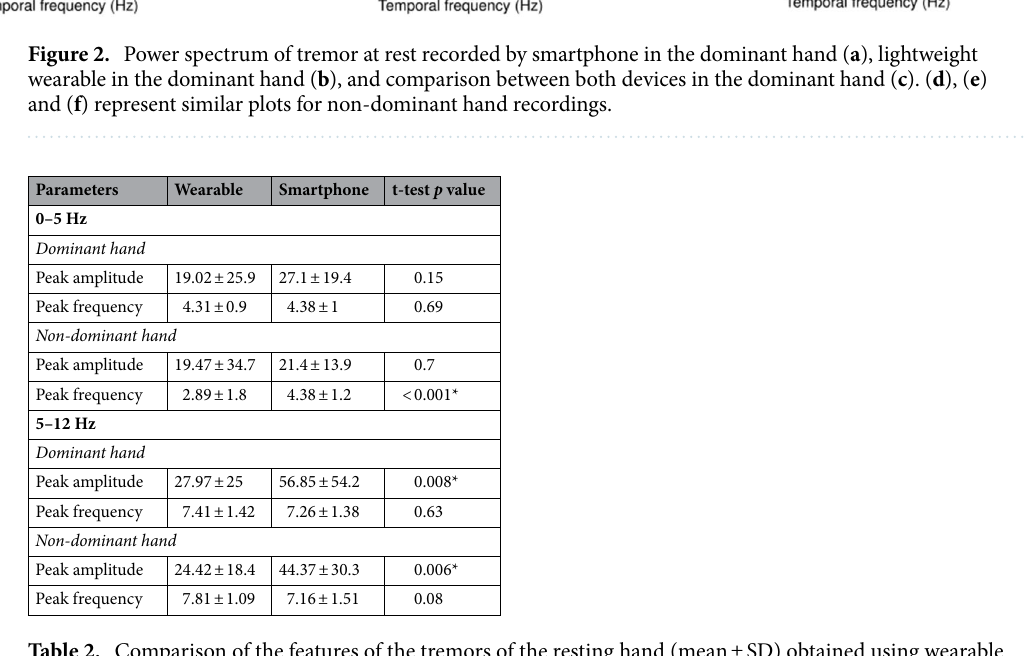
Table 2. Comparison of the features of the tremors of the resting hand (mean ± SD) obtained using wearable and smartphone devices. *Significant difference using the paired-t